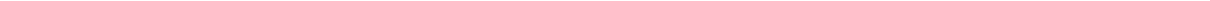
Fig. 3 A structurally novel acetal-functional anthracycline selectively targets leukemic blast cells and not nonmalignant lymphocytes within a human bone marrow biopsy. a Chromatographic arraying of Streptomyces specus was performed using split fl ow HPLC/UV/MS with polarity-switching mass scanning resulting in an array of highly characterized fractions from a crude extract of the baumycin producer S. specus . Primary cell preparations were prepared from AML patient biopsy. The metabolite array was incubated with heterogeneous cell samples, and the cells were then viability stained, fi xed, barcoded, and stained with antibodies for biomarker and surface marker expression. Standard gating was performed using biaxial plots of CD45 expression vs. SSC was used to determine cell-type subsets (blue gate: lymphocytes, red gate: blasts) that were each individually analyzed for γ H2AX and cCasp3 expression. b Structures of specumycin A1 and B1. c Biaxial plots of selected wells gated for lymphocytes and leukemia blasts. d Total ion current and selected extracted ion currents of metabolites within the metabolome of S. specus correlating to bioactive wells from assays against two patient samples. Bar graphs of percent of cells in the upper left quadrant of marker/viability gate (marker positive and viable cells). The solid red line is the arcsinh transformed median of the marker. For patient 015, the average cells collected per well were 3996 blasts (minimum 240) and 764 lymphocytes (minimum 66). For patient 001, the average collected per well was 1655 blasts (minimum 189) and 53 lymphocytes (minimum